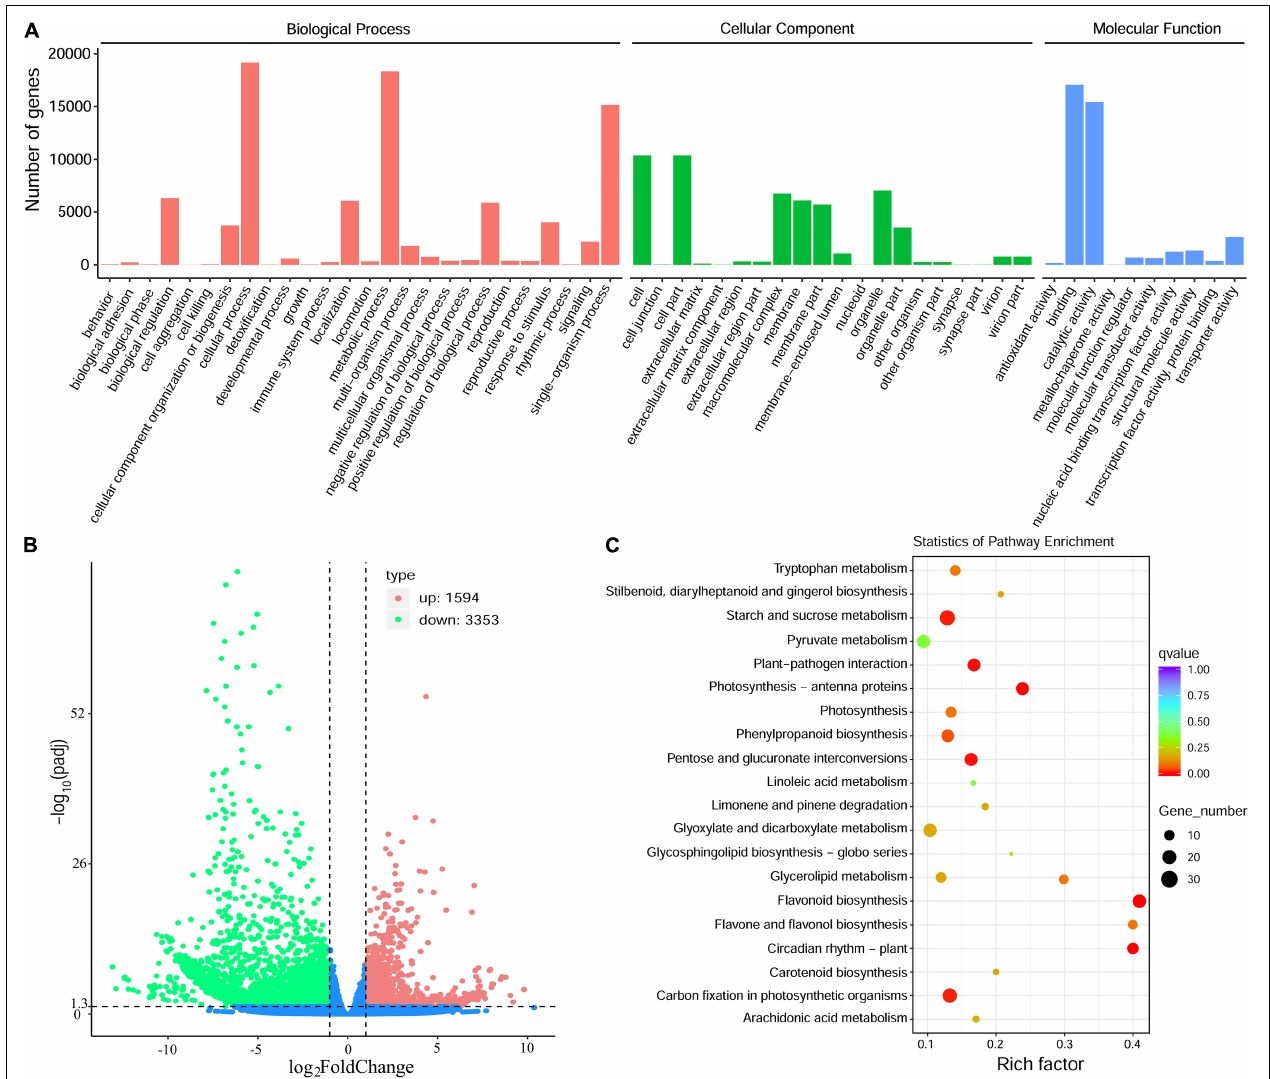
FIGURE 4 | Transcriptome sequencing of the Antarctic moss under UV-B light. (A) The classification of Gene Ontology of L. pyriforme unigenes. (B) The volcano plot showing the DEGs between UV-B radiation group and control group. The X-axis indicates fold change of gene expression (threshold, | log 2 (Treat/Control)| > 1), while the Y-axis means the statistically significant level (threshold, q-value < 0.005). (C) KEGG pathway enrichment of DEGs. Rich factor represents the ratio of the number of DEGs to the total number of annotated genes in this